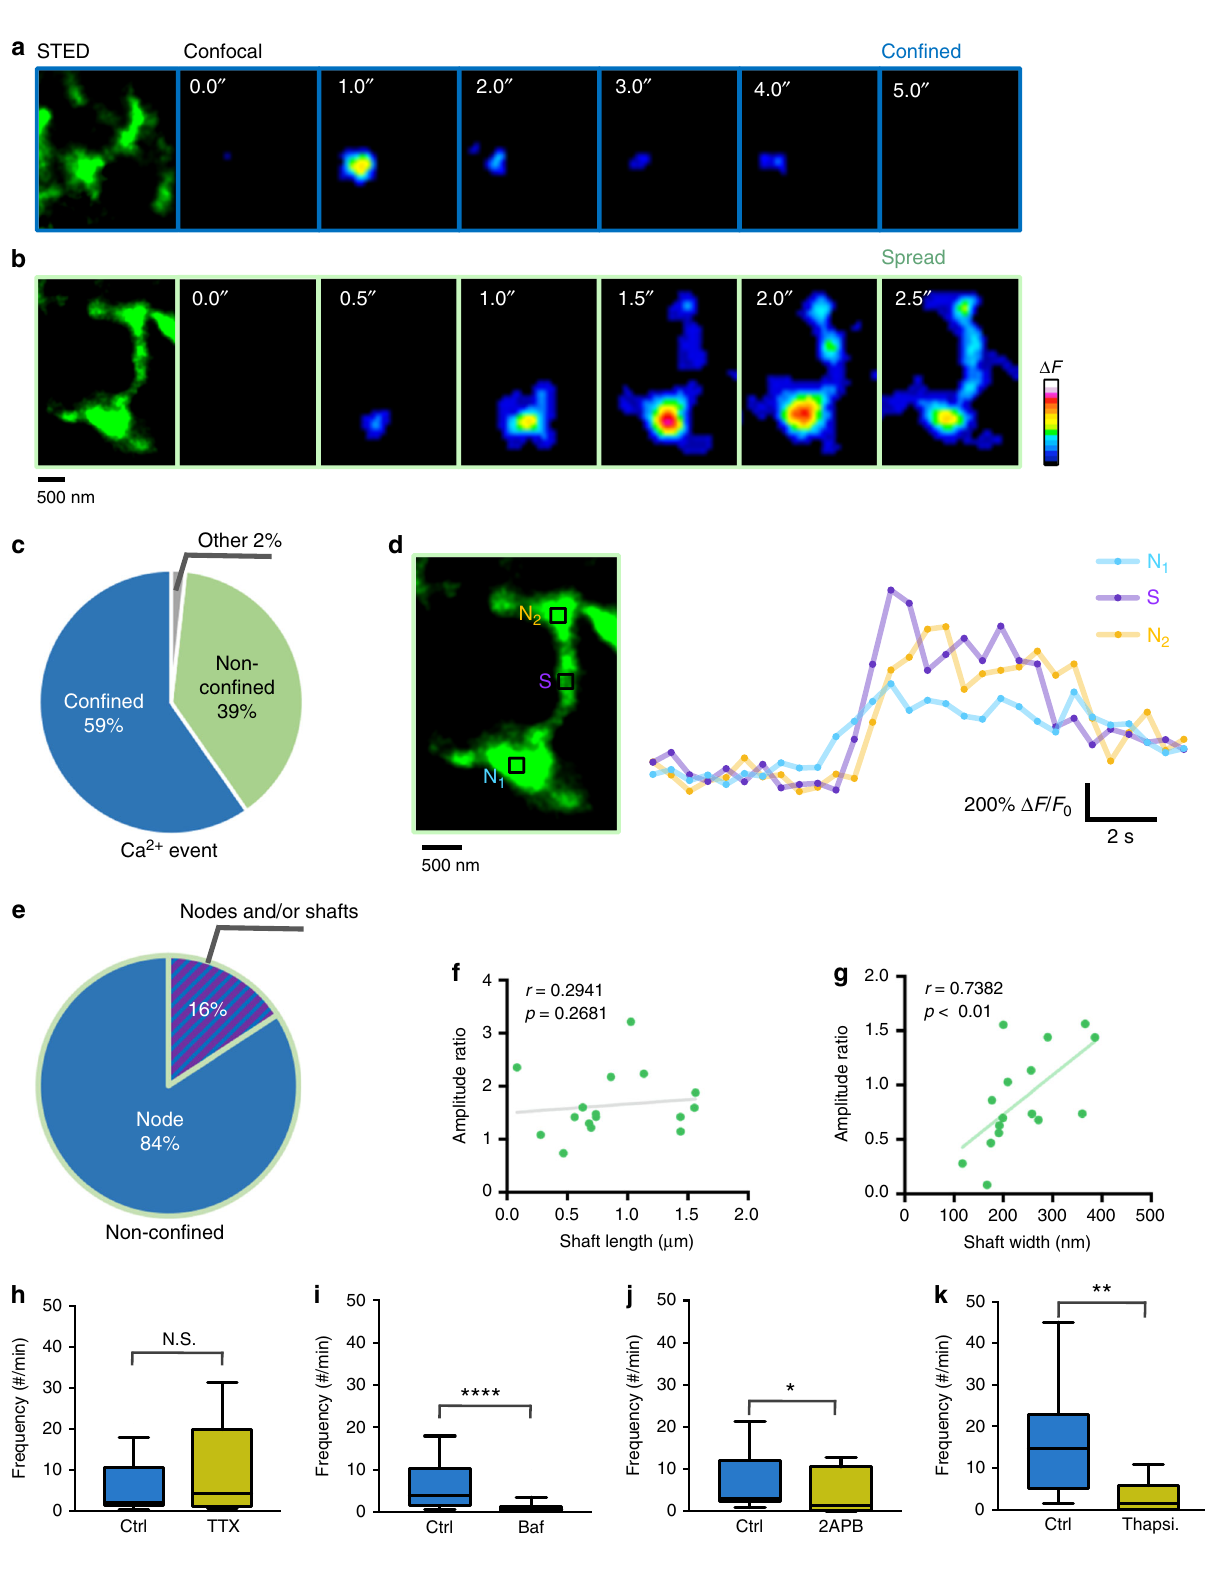
While the frequency of Ca 2 + transients was unaffected by TTX (Fig. 7h), it was signi fi cantly reduced in the presence of ba fi lomycin A1 (Fig. 7i), in line with the previous reports 4,28 . These results suggest that miniature synaptic events triggered the Ca 2 + transients. However, we cannot rule out drug effects on the potential acidic Ca 2 + stores 29 in